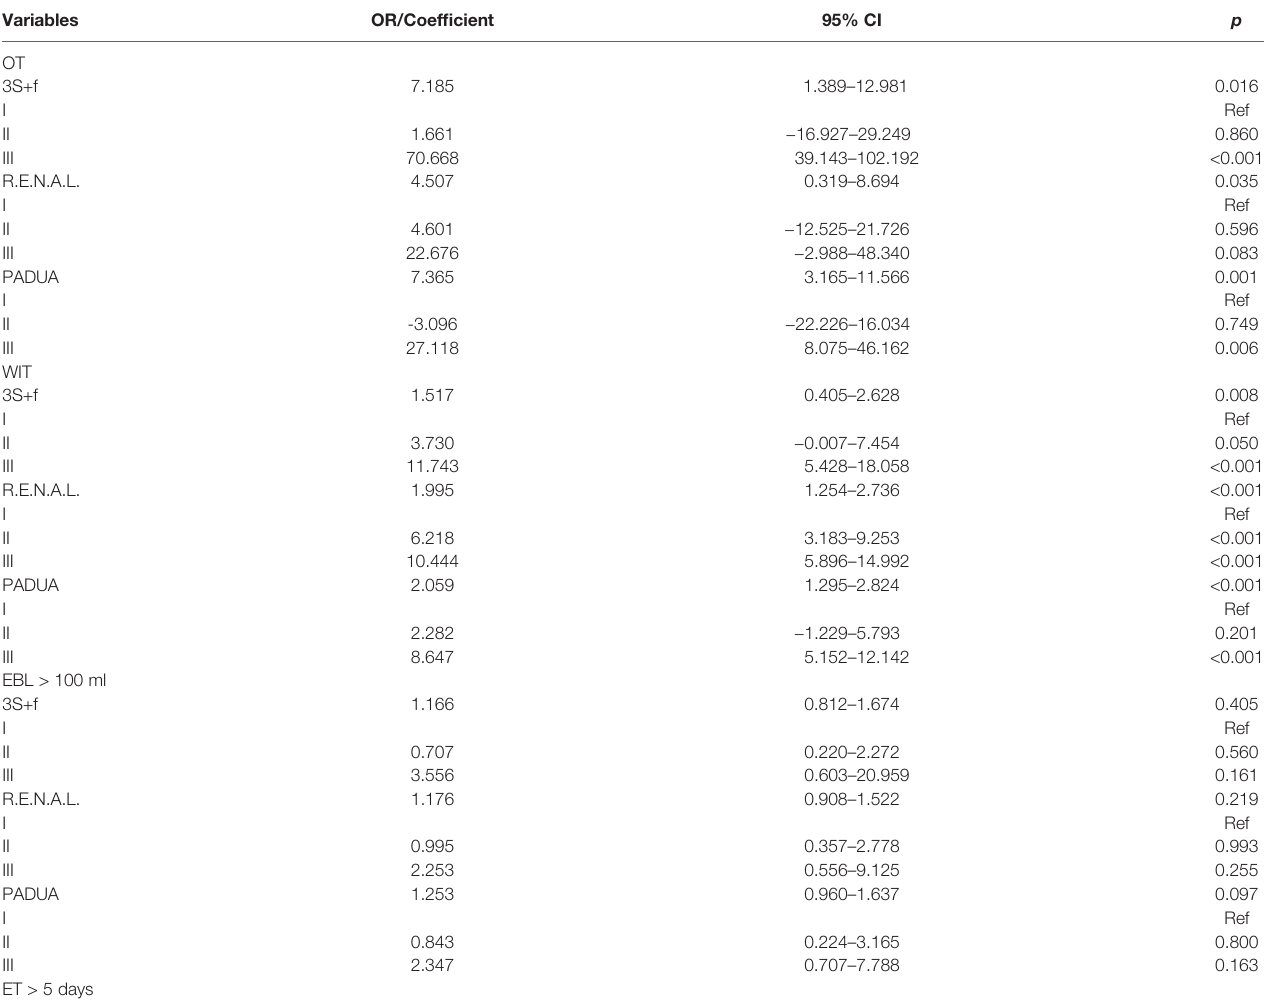
TABLE 5 | Multivariable binary regression analyses of nephrometry score systems and clinical